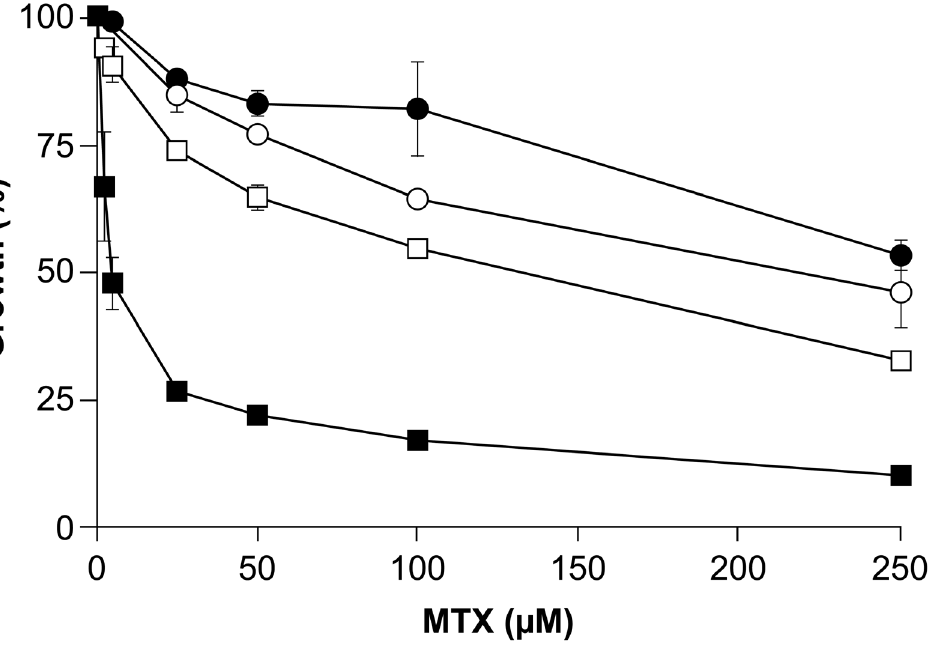
Figure 3. Role of thymidine kinase ( LinJ21.1450 ) in methotrexate susceptibility. Growth curves in the presence of methotrexate were determined for L. infantum wild-type cells (lines with circles) and the Lin5FU500.3 mutant (lines with squares), each transfected either with an empty vector (pSP72 a HYG a ) (black circles and black squares respectively) or with a thymidine kinase expression construct (pSP72 a HYG a - LinJ.21.1450 ) (white circles and white squares respectively). Average of three independent biological replicates. Transfection of TK in the mutant led to MTX susceptibility that was statistically different than the mock control (p , 0.05). doi:10.1371/journal.pntd.0002564.g003 PLOS Neglected Tropical Diseases |